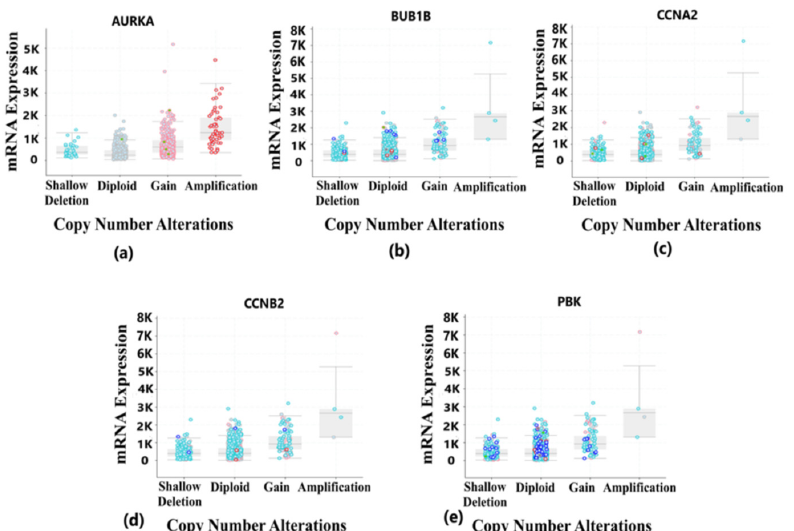
Figure 9. Copy number alteration deals with the deletions and amplification of genetic material fragments. This phenomenon is common in different cancer types and plays a vital role in the development and progression of cancer. This figure shows the copy number alterations in hub genes of BRCA. Light blue color dots represent shallow deletion, dark blue dots represent deep deletion, red dots represent gain, and green dots represent missense mutation. ( a ) Copy number alterations in the AURKA gene having most of the changes due to gain and amplification in the genetic materials. ( b ) Copy number alterations in BUB1B gene having most of the changes due to diploid, gain and shallow deletion in the genetic materials. ( c ) Copy number alterations in CCNA2 gene having most of the changes due to shallow deletion, gain and diploid in the genetic materials. ( d ) Copy number alterations in CCNB2 gene having most of the changes due to gain and amplification in the genetic materials. ( e ) Copy number alterations in PBK gene having most of the changes due to gain and amplification in the genetic materials. Table 4. Table summarizing the information related to genetic alterations in breast cancer.